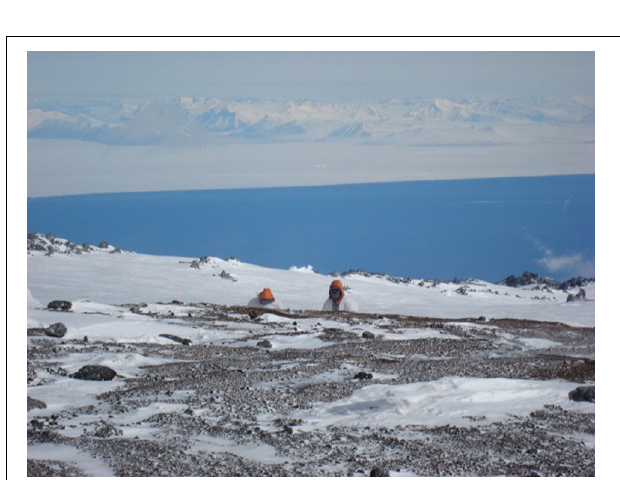
FIGURE 7 | The northern tip of that Antarctic peninsula where the soils receive liquid water from meltwater and summer rain.